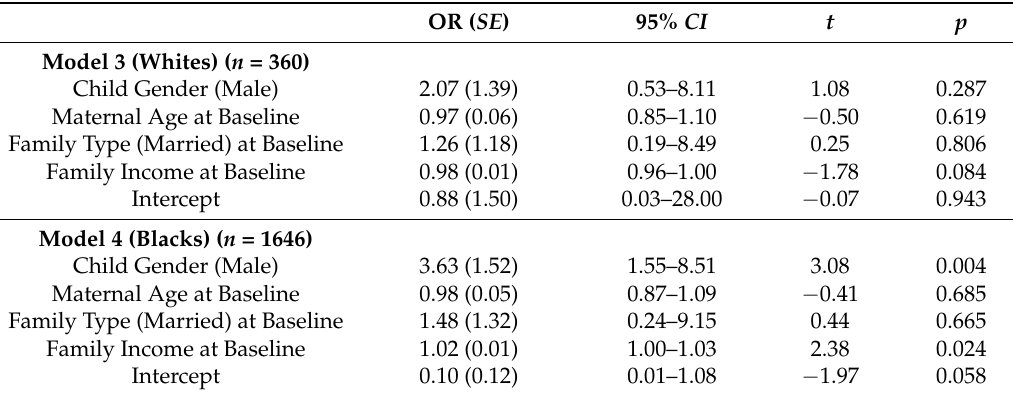
Table 3. The results of two logistic regression models by